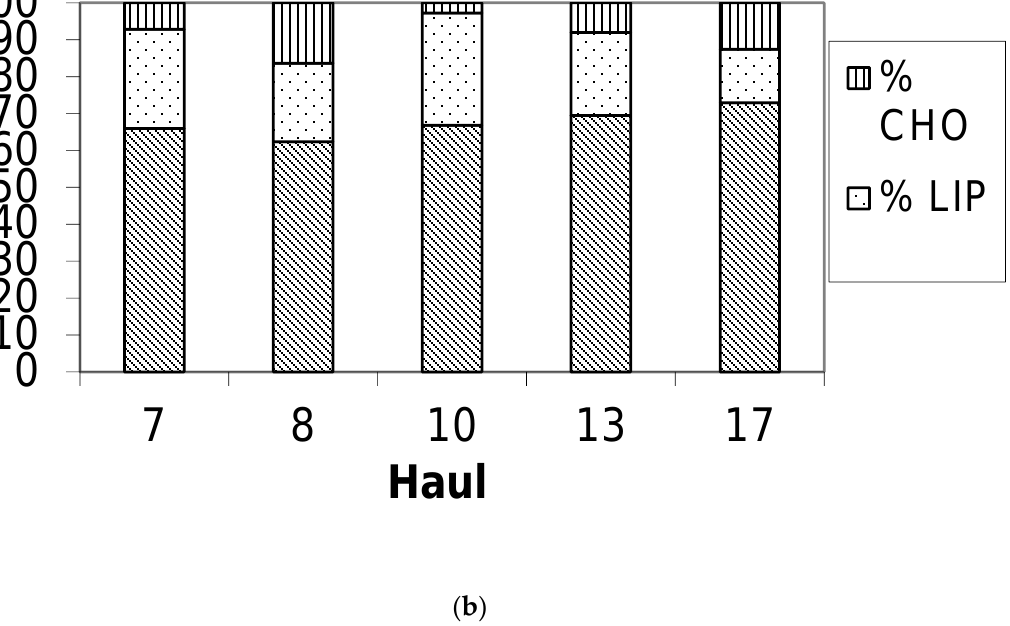
Figure 2. ( a ) Percent biochemical composition of E. superba in the selected hauls; ( b ) percent bio- chemical composition of E. crystallorophias in the selected hauls. CHO = carbohydrates, LIP = lipids, PRT = proteins.